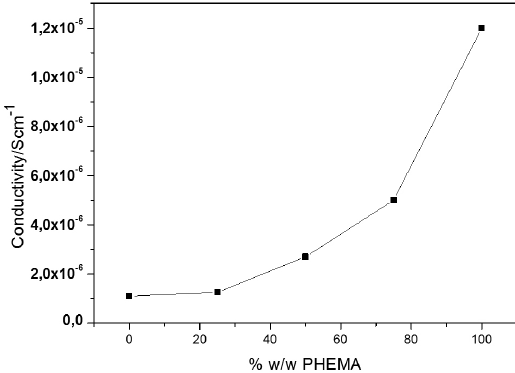
Figure 5. Curve of ionic conductivity of samples neat polymer and polymer